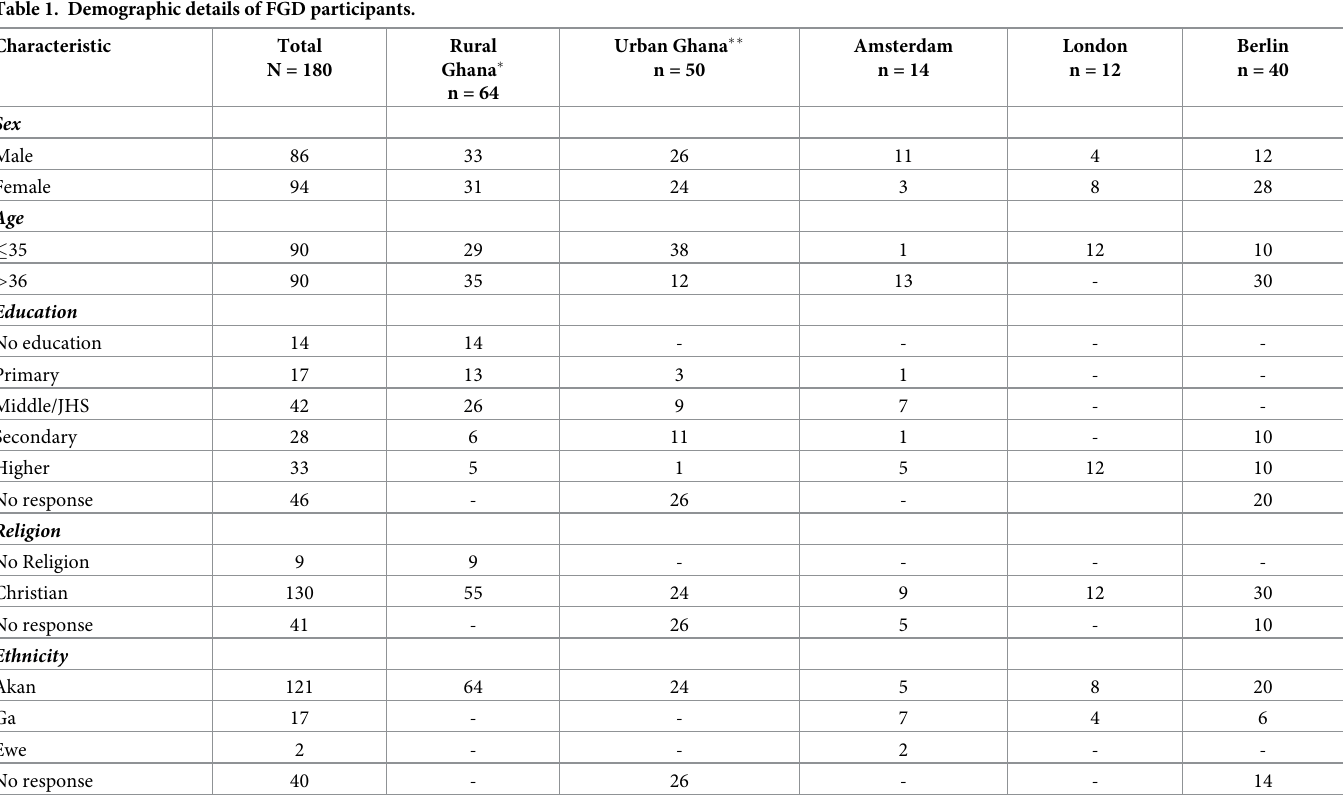
Table 1. Demographic details of FGD